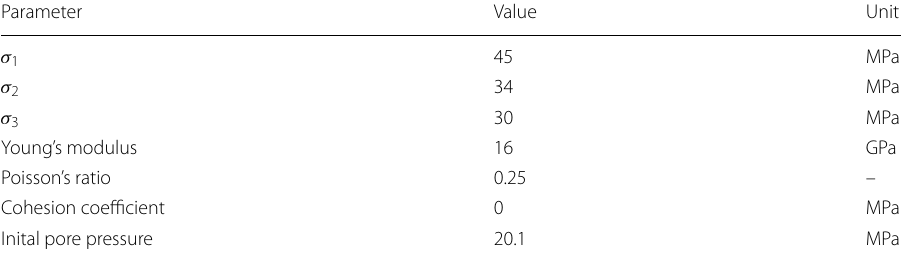
The stress tensor values are based on the work of Mechelse (2017)